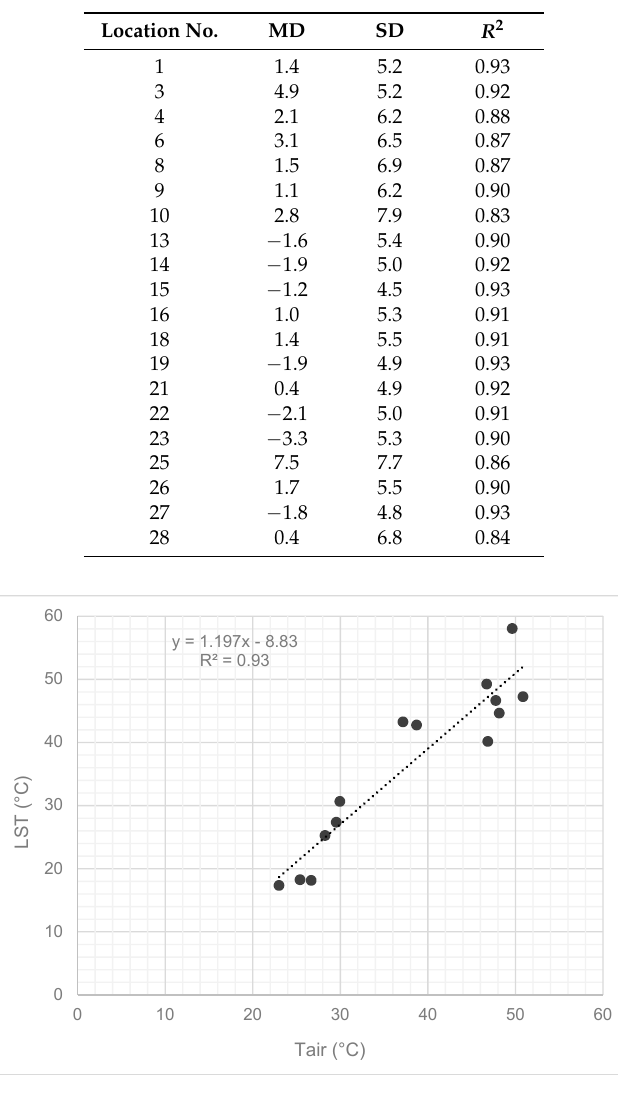
Figure 5. Slope and R 2 for the linear best-fit line between hourly T air measurements and LST from the Landsat imagery. The “best-fit” 1:1 ratio level is show as a dashed horizonal line. 4.2.3. Comparisons between All Three Measurements Across all measurement locations in the study area, the hourly and daily T surface was commonly higher than either maximum daily T air or LST (Figures 3 and 6), although there were a few exceptions to that pattern. Most notably, the T surface was lower than the T air for 20% of the hourly observations collected in 2017, mainly during colder months (winter and autumn), and the T surface was lower than the LST for 12% of the hourly observations from summer and autumn Landsat fly-over dates.